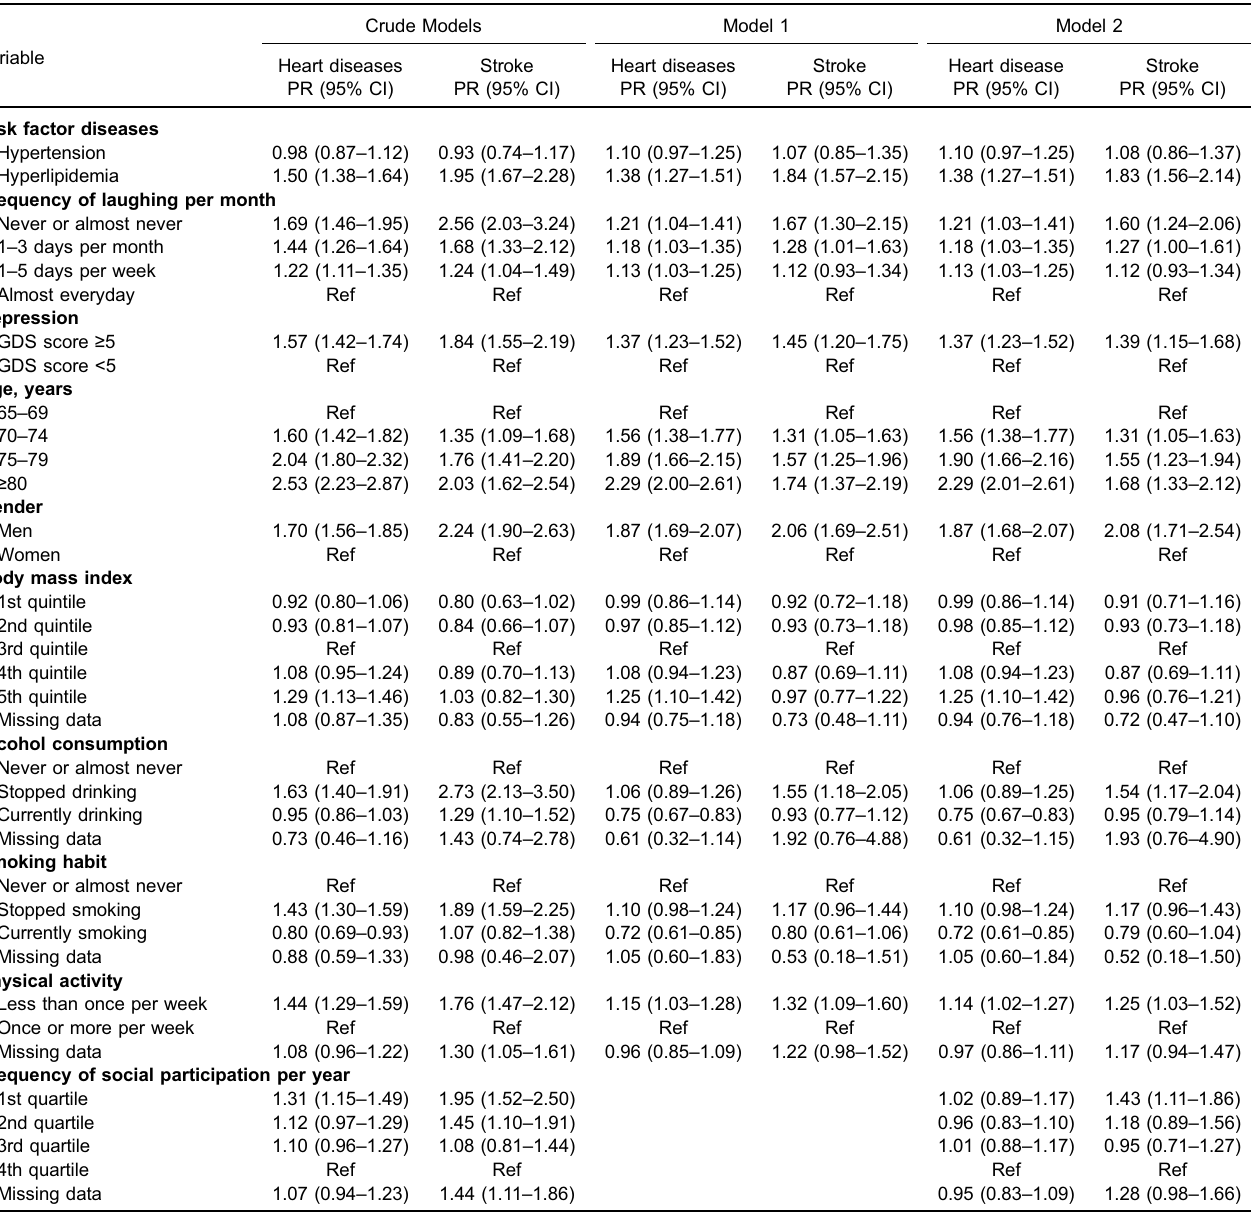
Table 3. Prevalence ratio and con fi dence intervals for heart diseases and stroke